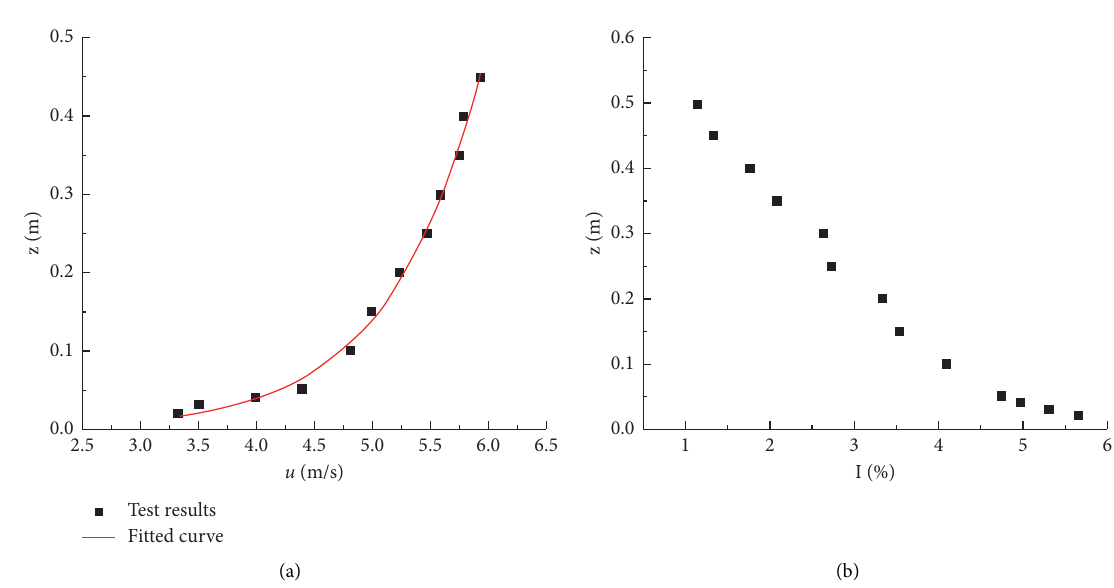
Figure 2: Profiles of the mean wind and turbulence intensity. (a) Wind velocity profile. (b) Turbulence intensity